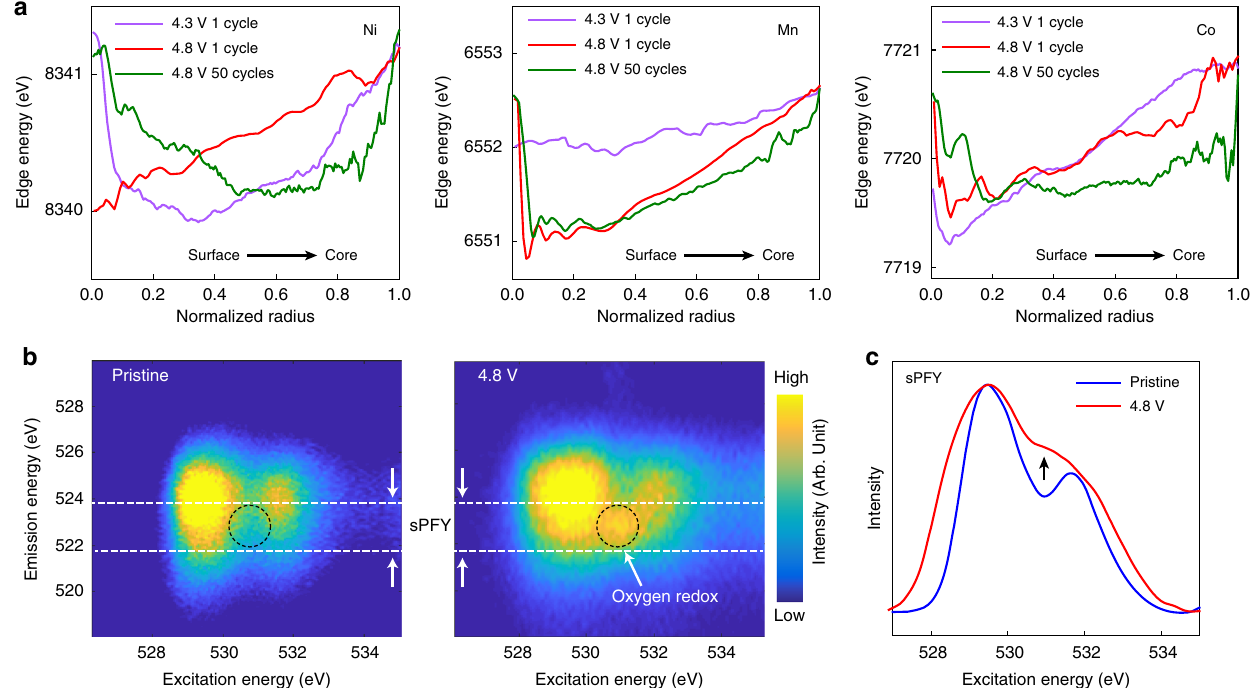
Fig. 4 Depth-dependent redox behaviors in the LirNMC layered oxide cathode. The variations of the edge energies for all the three transition metal cations (Ni, Mn and Co) are shown in left, middle and right of panel ( a ), respectively. Soft x-ray RIXS data on the pristine and the charged (to 4.8 V in the fi rst cycle) LirNMC samples are shown in panels ( b ). The comparison of the sPFY signals is shown in panel ( c